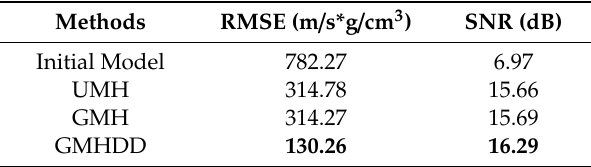
Table 1. The RMSE, signal noise ratio (SNR) of three methods.